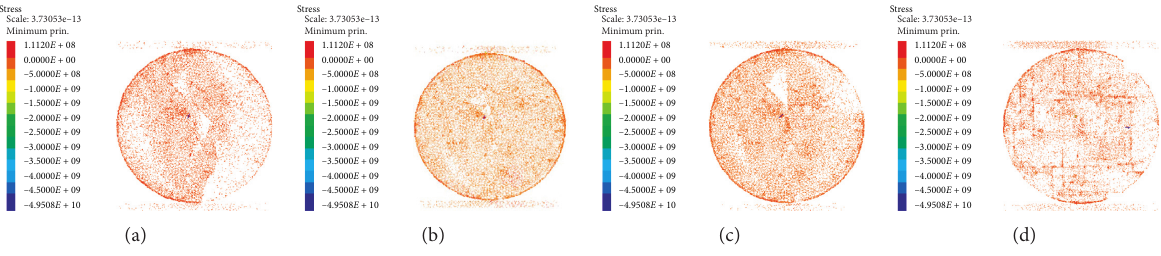
Figure 31: Splitting stress cloud diagrams of shale with natural fractures. (a) 1 crack. (b) 2 cracks. (c) 3 cracks. (d) Natural crack